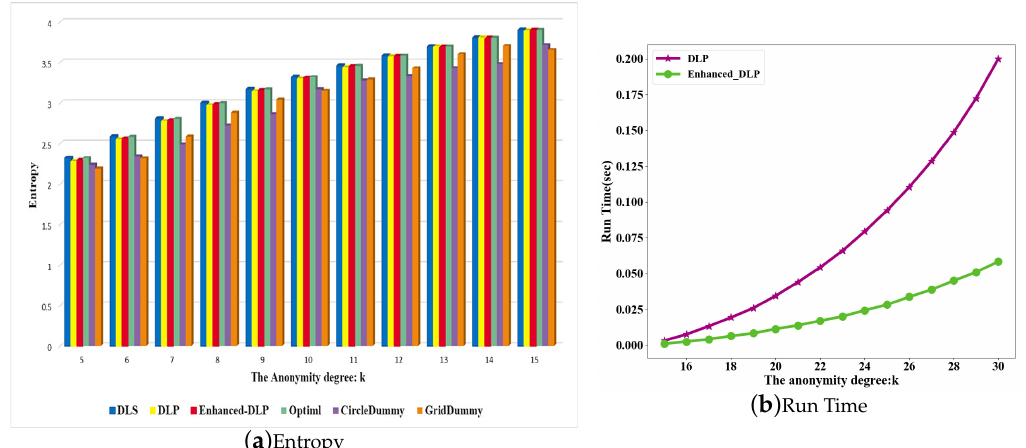
Figure 4. Scenario 2: Entropy and run time.